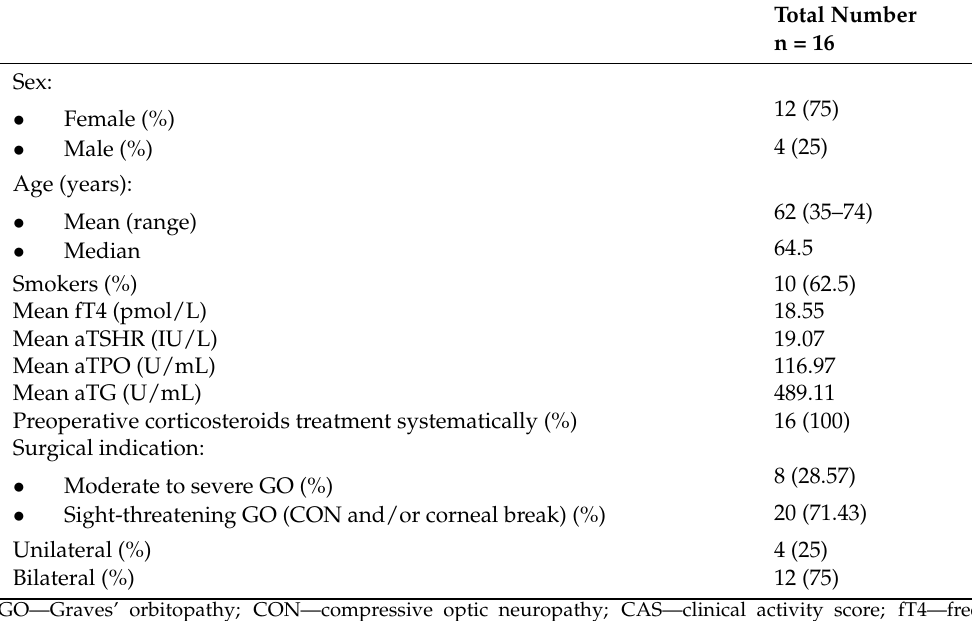
Table 1. Characteristics of 16 patients (28 orbits) at surgery.